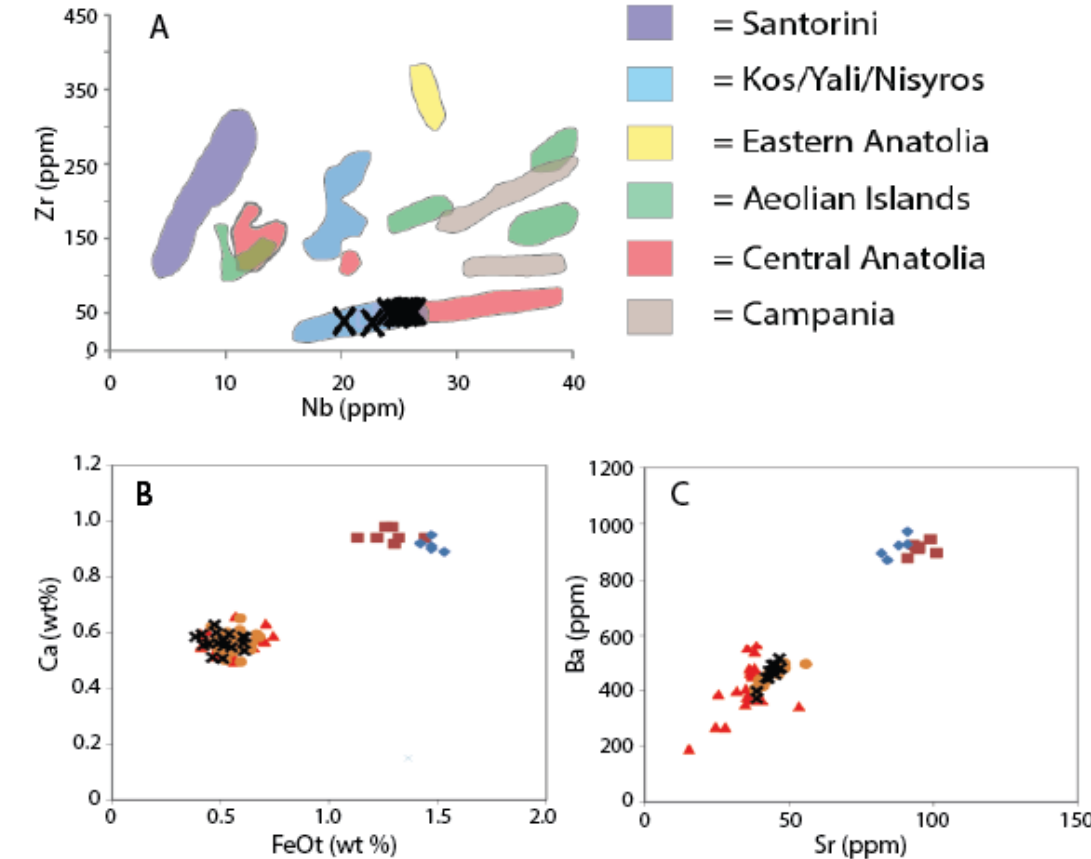
Figure 4. Geochemical comparison (juvenile glass) of an example marine tephra deposit (black crosses) with a known age found in an Eastern Mediterranean marine sediment core (ODP 967) to undated proximal deposits from various candidate volcanoes or volcanic regions in the Eastern Mediterranean. ( A ); adapted from [21], shows that the analyses most closely match proximal deposits on the islands of Kos, Yali and Nisyros. (( B , C ); adapted from reference [22]) show that the marine tephra (black crosses) closely matches the major element (calcium and iron) composition ( B ) of two of the undated proximal deposits of the Kos/Yali/Nisyros volcanic system (red triangles and orange circles), but just one of these deposits (orange circles) when trace elements (Ba and Sr) are considered ( C ). The marine tephra deposit is therefore correlated to, and gives a date for, the proximal deposit represented by the orange circles.